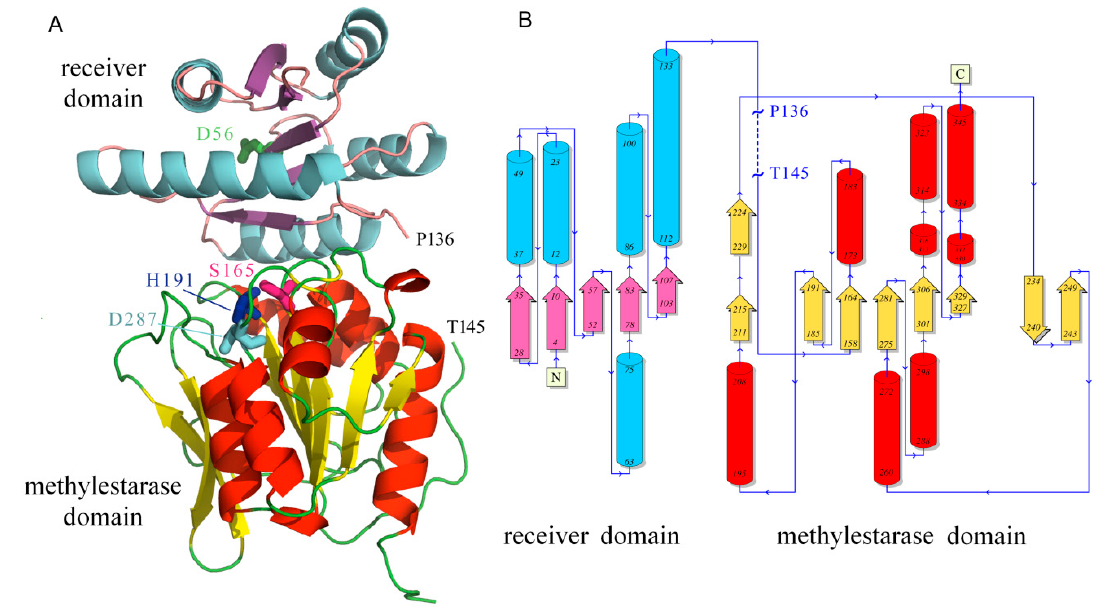
Figure 6. The three dimensional structure of P. atrosepticum CheB. ( A ) Ribbon diagram of the structure. The gap observed due to lacking electron density is indicated (P136 to T145). The phosphoryl group accepting aspartate (D56), as well as the residues that form the methylesterase catalytic triad (S165-H191-D287), are shown in stick mode. ( B ) Secondary structure elements: tubes: α -helix; arrows: β -strand. The figure was produced using PDBsum [53].